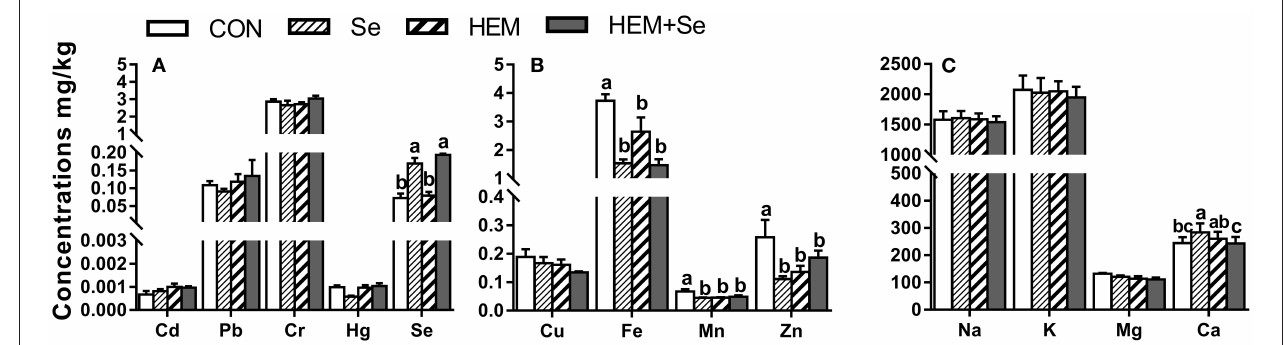
FIGURE 2 | The effect of selenium and cadmium, lead, mercury, chromium Co-treatment on the concentrations of ions in the egg white (Wet Basis mg/kg) of laying hens from 63 to 74 wk of age. CON, corn-soybean meal basal dietary; Se = the basal dietary supplemented with 0.4 mg/kg selenium from selenized yeast (the selenium concentration was 0.14 mg/kg in the CON diet); HEM, the basal dietary supplemented with 5 mg/kg cadmium from CdCl 2 , 50 mg/kg lead from Pb(NO 3 ) 2 , 3 mg/kg mercury from HgCl 2 and 5 mg/kg chromium from CrCl 3 ; HEM + Se, the HEM dietary supplemented with 0.4 mg/kg selenium from selenized yeast. (A) The effect of selenium and cadmium, lead, mercury, chromium Co-treatment on the concentrations of cadmium, lead, chromium, mercury, selenium in the egg white. (B) The effect of selenium and cadmium, lead, mercury, chromium Co-treatment on the concentrations of copper, iron, manganese, zinc in the egg white. (C) The effect of selenium and cadmium, lead, mercury, chromium Co-treatment on the concentrations of sodium, potassium, magnesium, calcium in the egg white. a,b,c Bars without a shared common letter are significantly different ( p < 0.05). Data show the mean ± SEM ( n = 10).